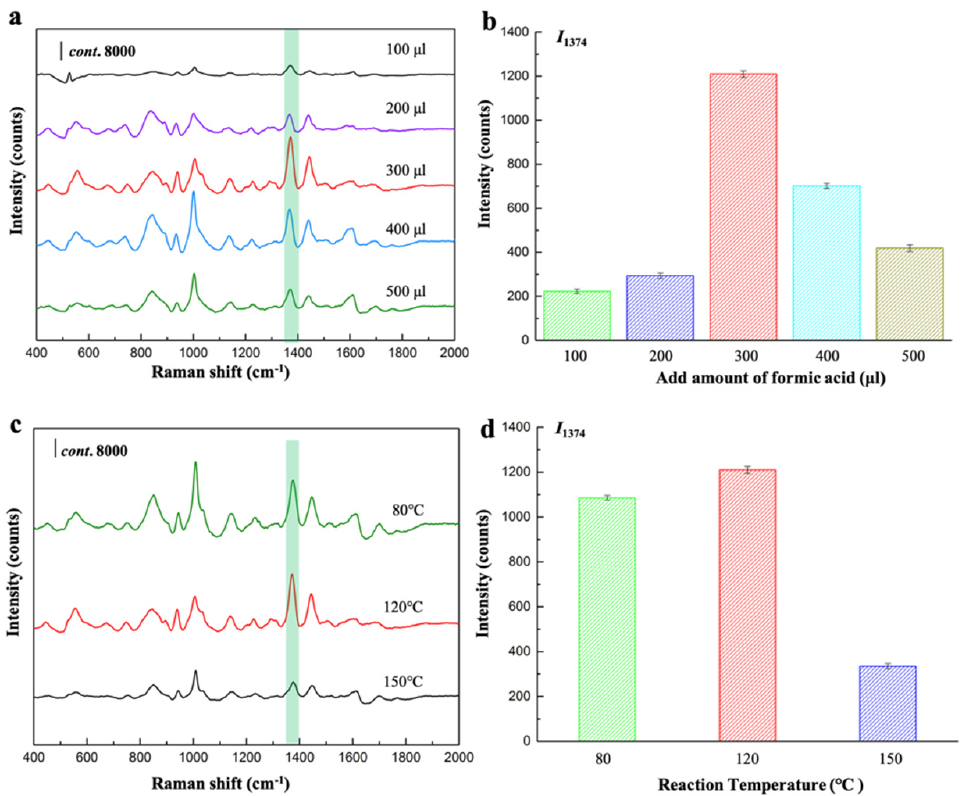
Figure 6. ( a , c ) SERS spectra of thiram; and ( b , d ) the comparison of I 1374 in the presence of Au@BUT-17 prepared with the increased amount of formic acid and the reaction temperature.